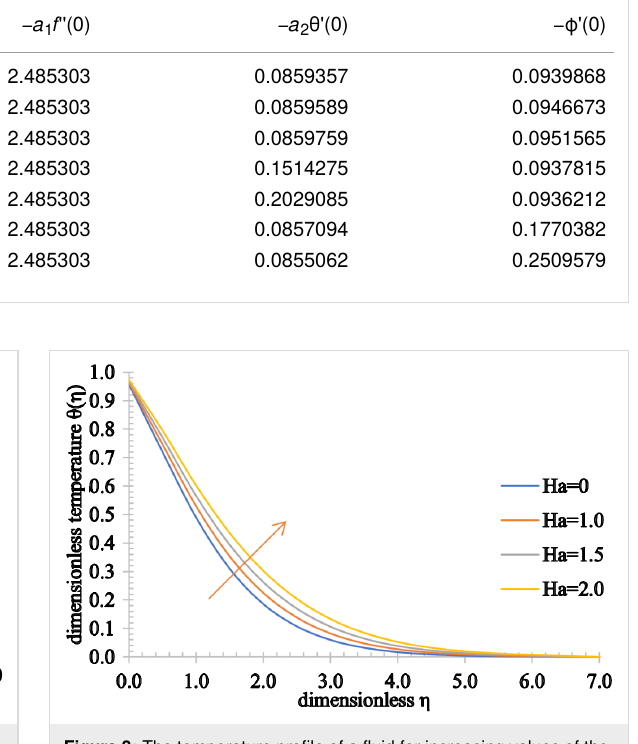
Figure 3: The temperature profile of a fluid for increasing values of the Hartmann number, Ha